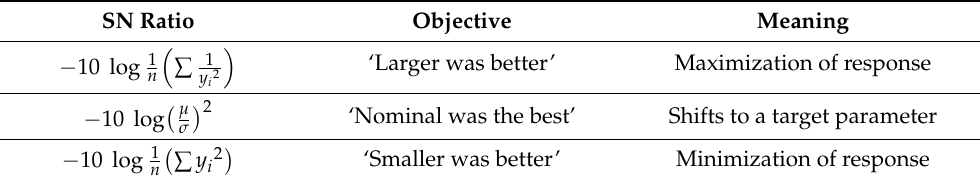
Table 2. Signal-to-noise (SN) ratios with the objectives and their meanings [36]. SN Ratio Objective Meaning (cid:16) (cid:17) ∑ 1 ‘Larger was better’ Maximization of response − 10 log 1 n y i 2 (cid:1) 2 ‘Nominal was the best’ Shifts to a target parameter − 10 log (cid:0) µ σ (cid:0) ∑ (cid:1) − 10 log 1 ‘Smaller was better’ Minimization of response y i 2 n